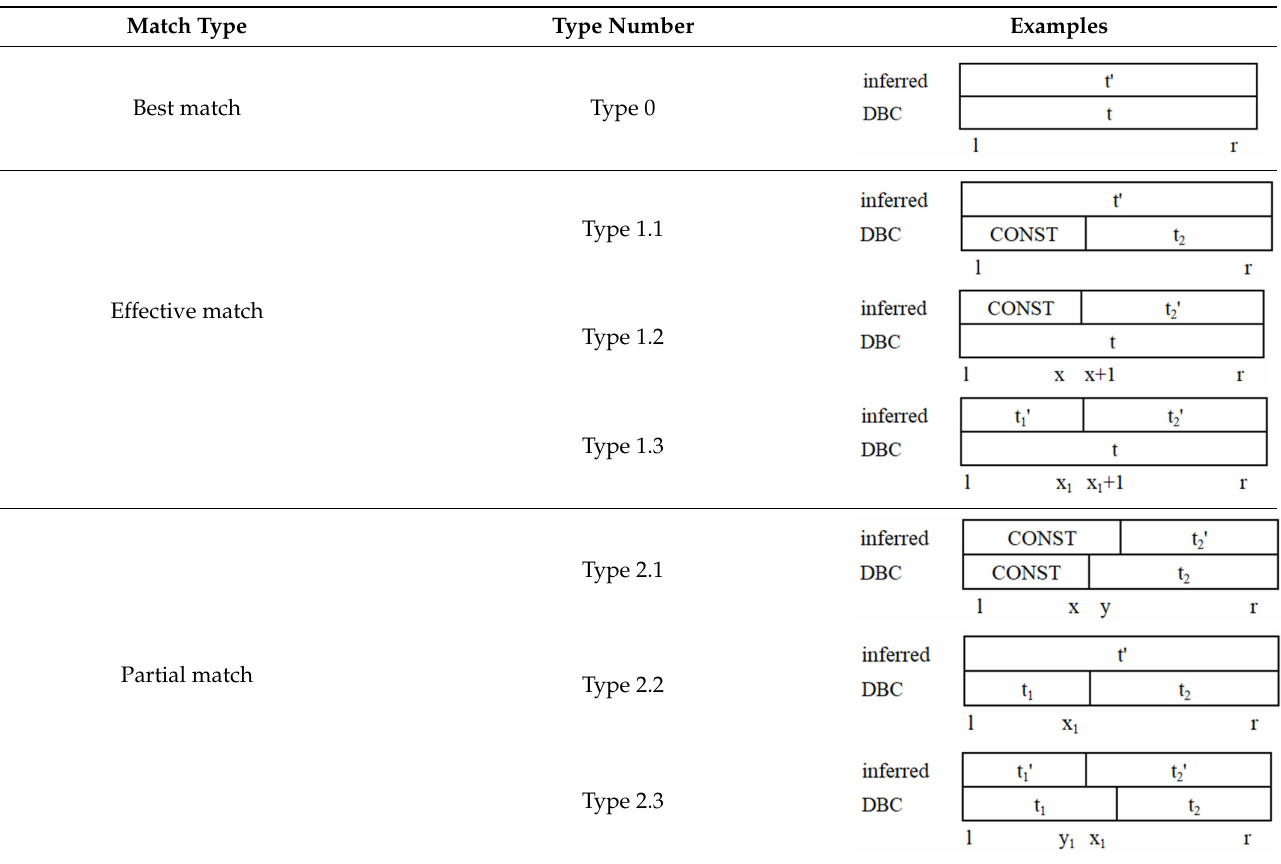
Table 7. Examples of match